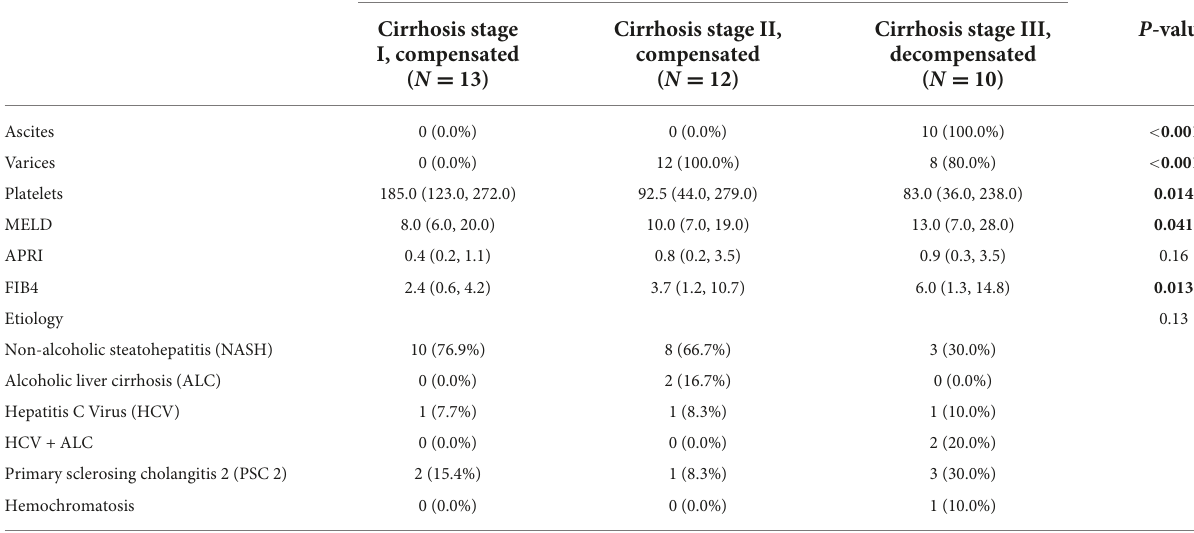
TABLE 2 Comparison of characteristics across disease stage for the cirrhosis study population. Median (minimum, maximum) or No. (%) of